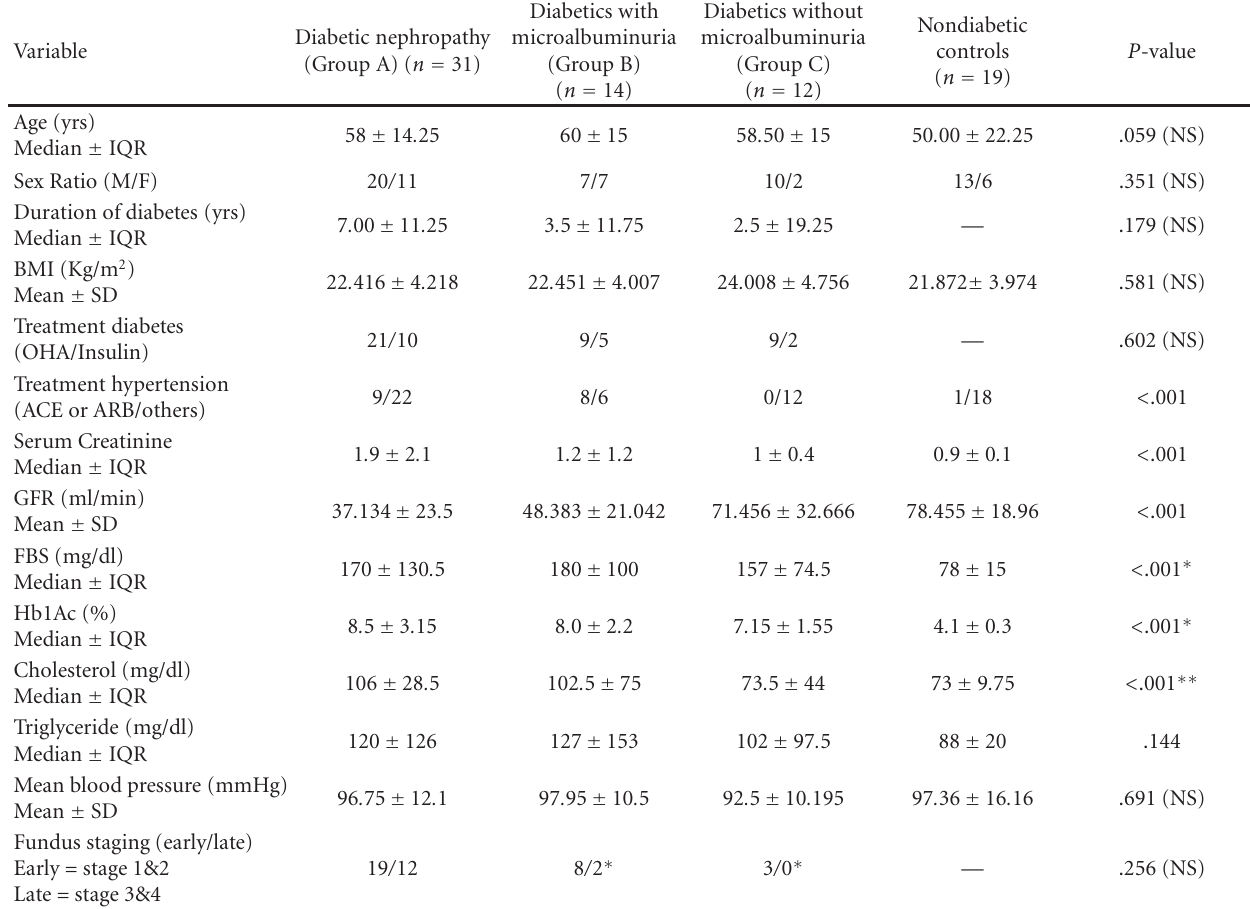
Table 1: Baseline characteristics of di ff erent